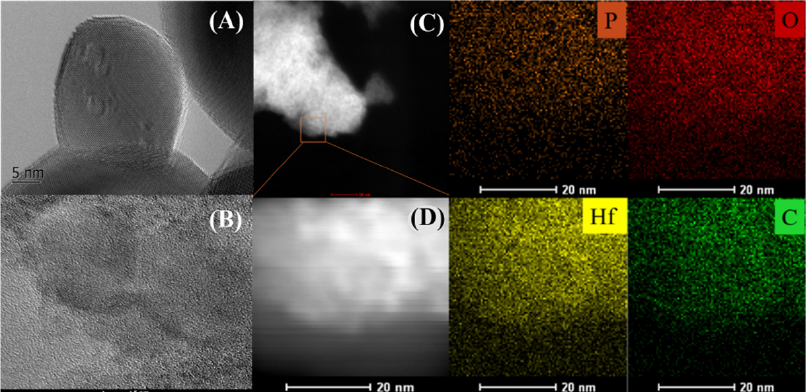
Figure 3. HR-TEM diagrams of ( A ) HfO 2 and ( B ) PhP-Hf (1:1.5), STEM-HAADF images ( C , D ), and elemental (P, O, Hf, C) mappings of PhP-Hf.